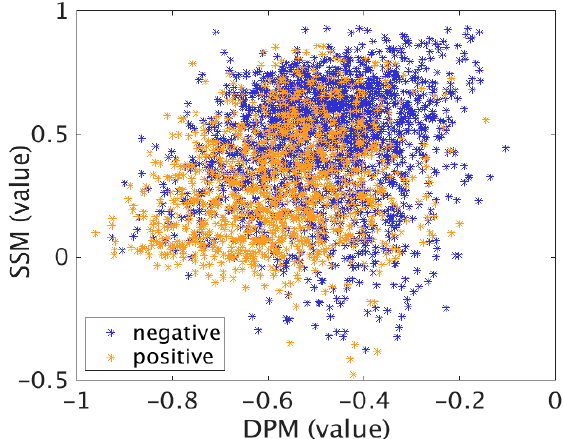
Figure 5. The distribution of support vector machine (SVM) training data. Yellow asterisks and blue asterisks represent positive and negative samples, respectively. DPM and SSM represent the value of DPM (Difference Probability Mean) and SSM (SSIM Mean) mentioned in Section